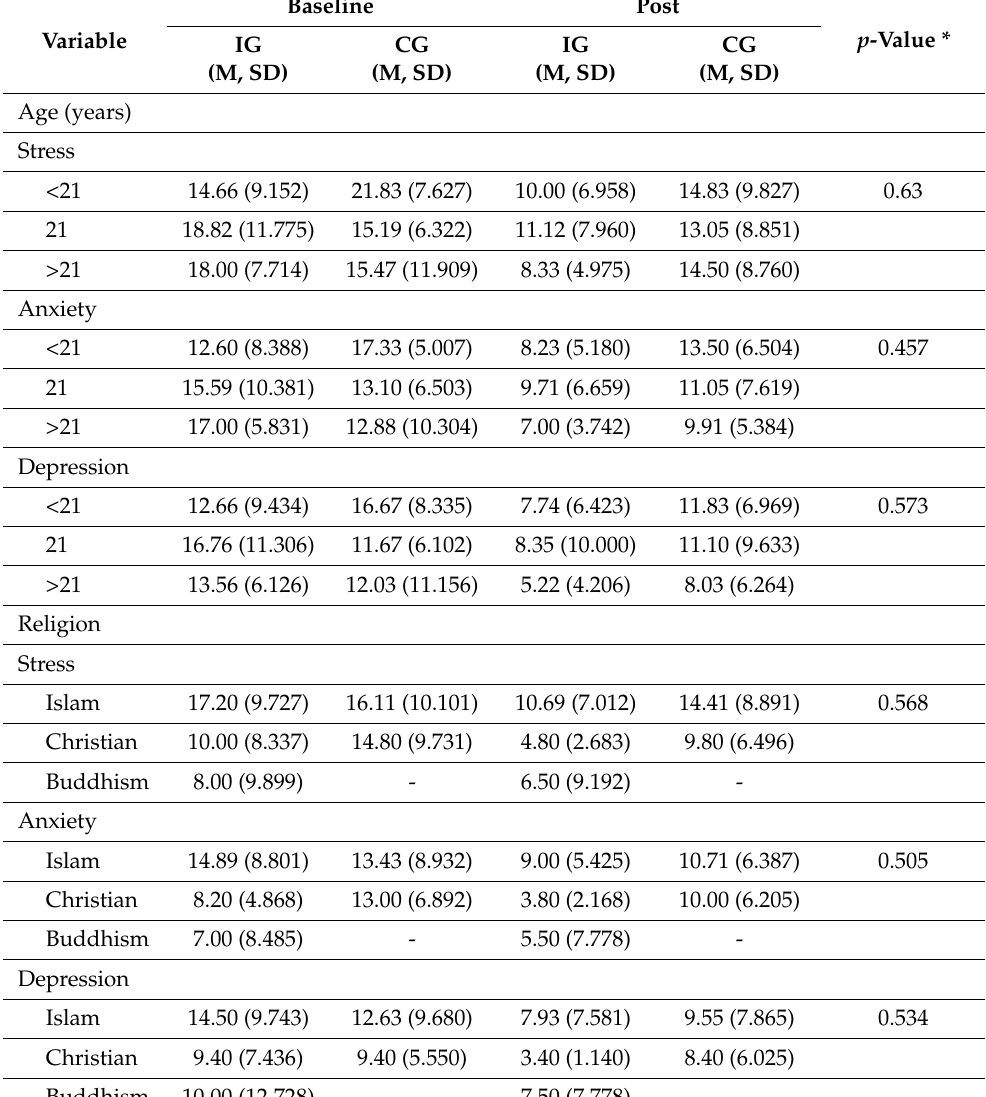
Table 4. Mean scores (standard deviations) based on age and religion of